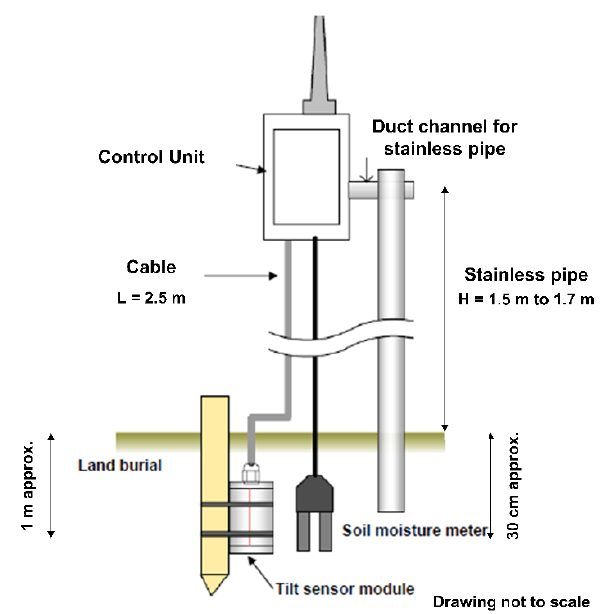
Figure 4. Schematic arrangement of sensor unit [46].